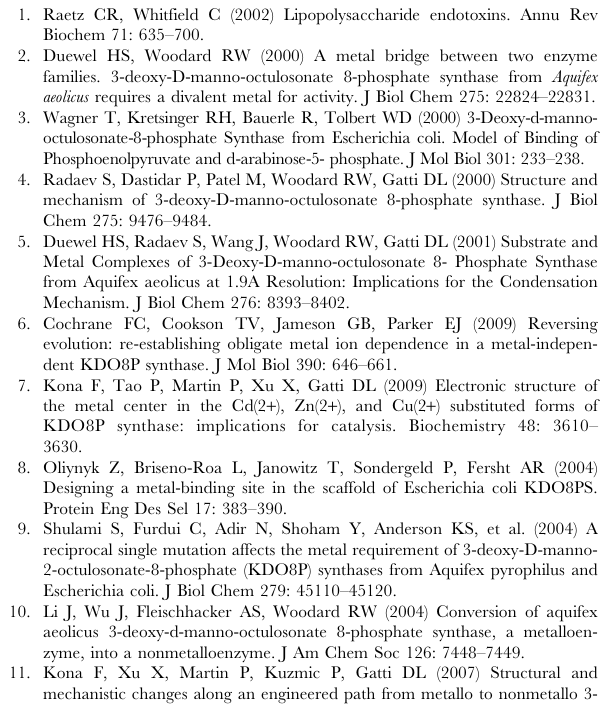
Table S2 Contribution to KDO8PS stability from coevolving pairs with score . 5 s in the ZRes matrix of a MSA of 165 KDO8PS sequences (MSA S3) in which the highest identity allowed between any two sequences is 86%. DD G’s are in kcal/ (DOC) Table S3 Correlation coefficients between the vectors of MI scores for i,j pairs above a threshold s value and the vectors representing the average effect of those pairs on the stability of KDO8PS, based on a MSA of 165 KDO8PS sequences (MSA S3) in which the highest identity allowed between any two sequences is 86%. (DOC) MSA S1 MSA in fasta format of all KDO8P synthases. (FASTA) MSA S2 MSA in fasta format of all KDO8P synthases with only the positions corresponding to the sequence of Nm. KDO8PS (Uniref entry 9JZ55) retained. (FASTA) MSA S3 MSA in fasta format of KDO8P synthases with no more than 86% identity between any two sequences. Only the positions corresponding to the sequence of Nm. KDO8PS (Uniref entry 9JZ55) were retained. Table S4 Correlation coefficients between the vectors of MI scores (based on a MSA of 249 sequences) for i,j pairs above a threshold s value and the vectors representing the average effect of those pairs on the stability of Atp12p.